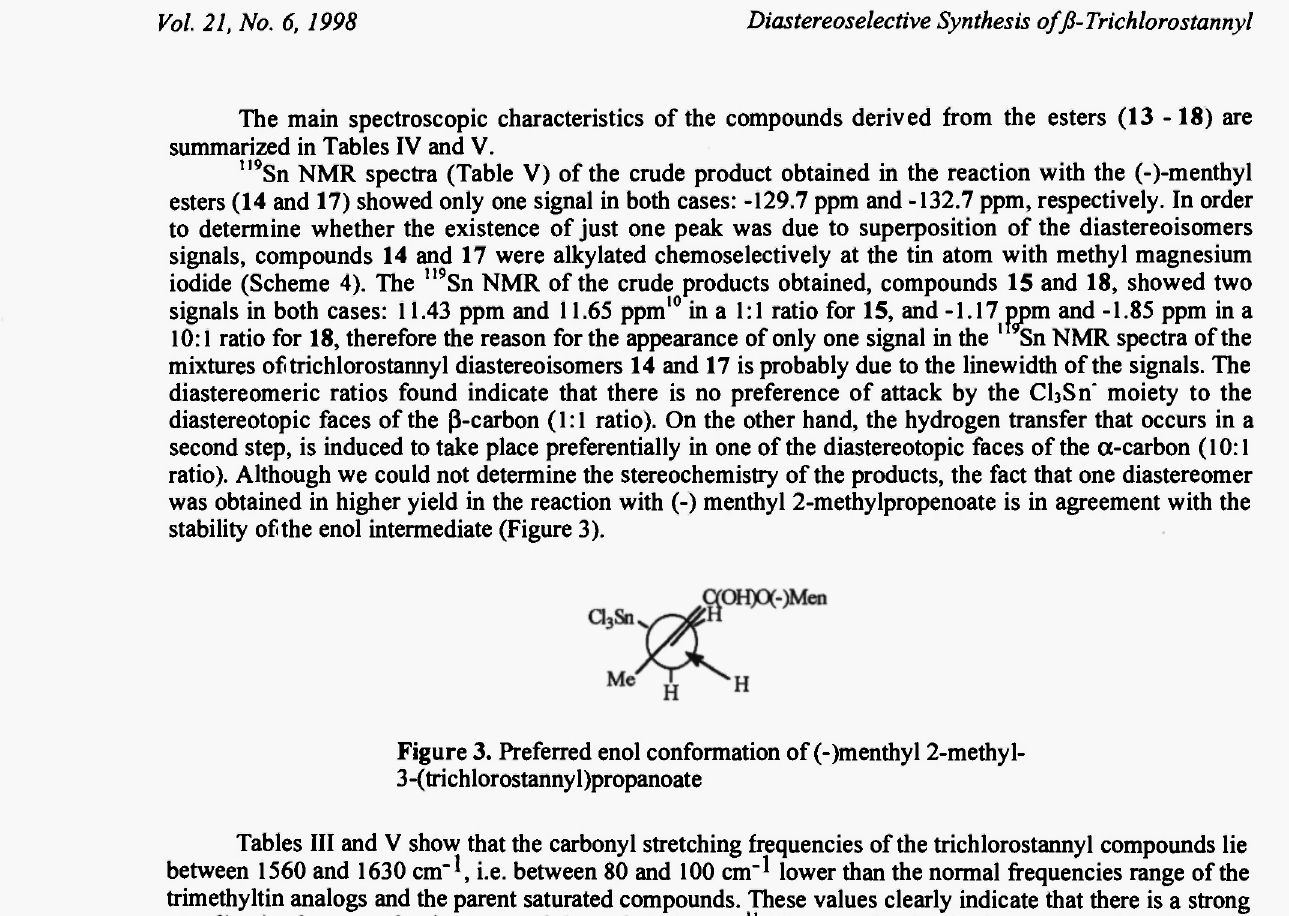
Figure 3. Preferred enol conformation of (-)menthyl 2-methyl-